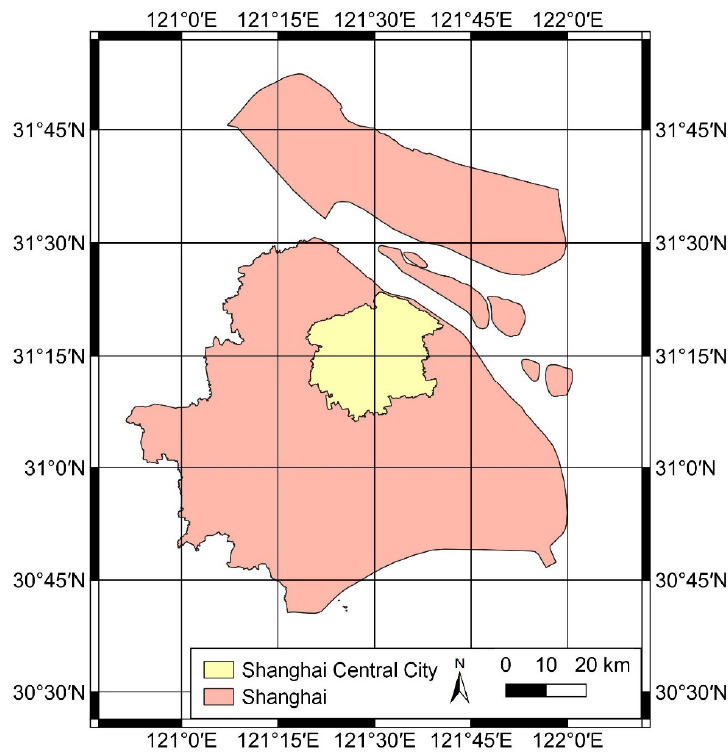
Figure 3. Research area of this paper.